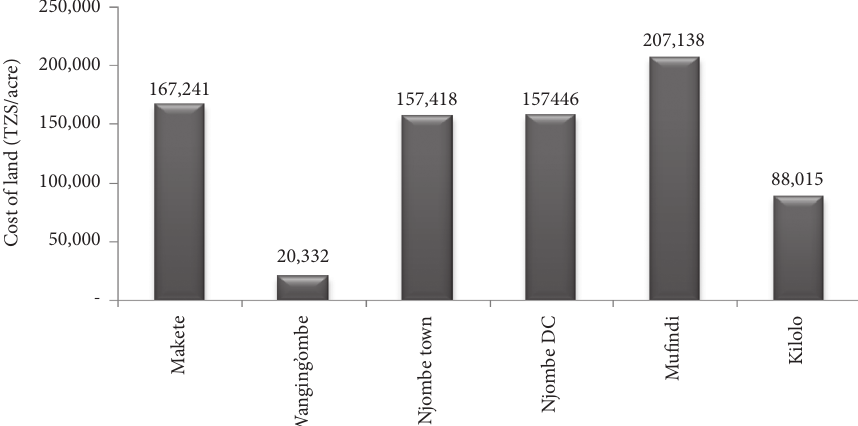
Figure 3: Cost of land in the study districts (source: own field